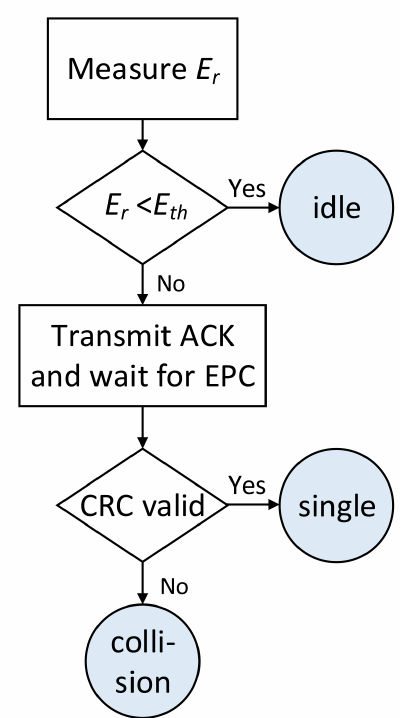
Figure 8. Flow diagram to differentiate the types of tag responses.